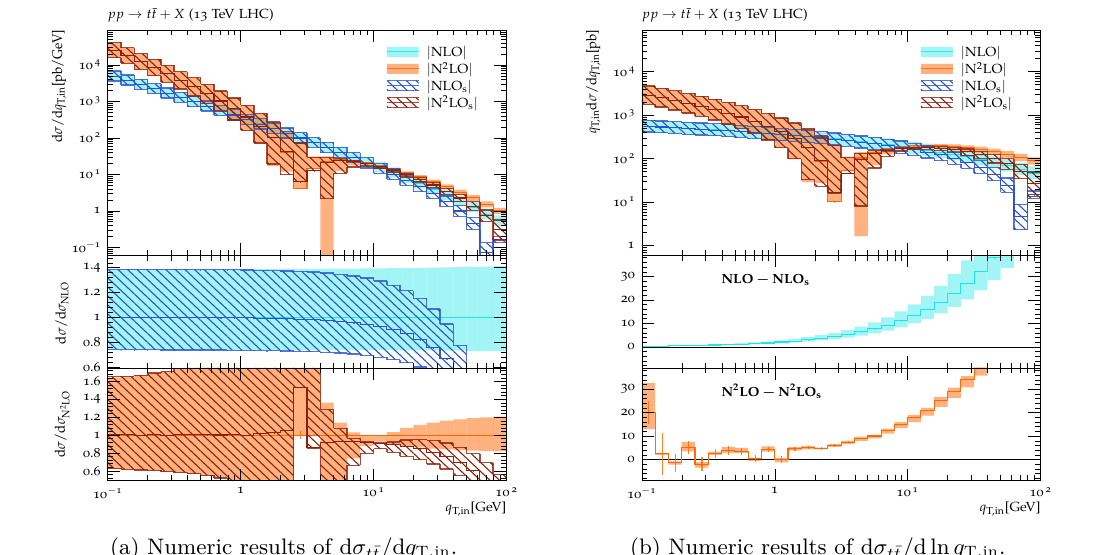
Figure 5 . The fixed-order results of the q T , in and the weighted q T , in spectra of the process pp t ¯ t + X at √ s = 13 TeV. NLO/N 2 LO represents the differential cross section calculated in → the full QCD, while NLO s /N 2 LO s encodes the leading singular behaviour derived from SCET II +